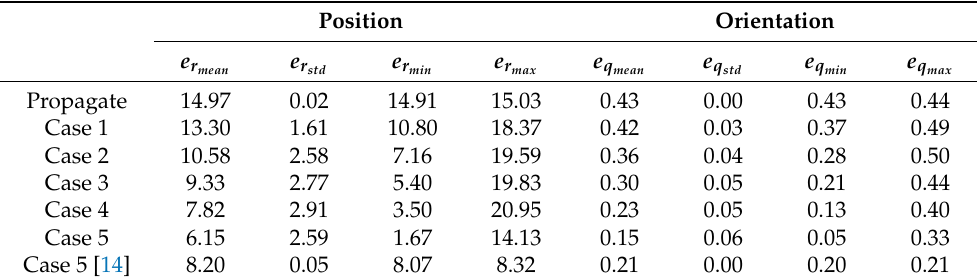
Table 5. Position (m) and quaternion error statistics across 100 simulations of all vehicles for Scenario 1.